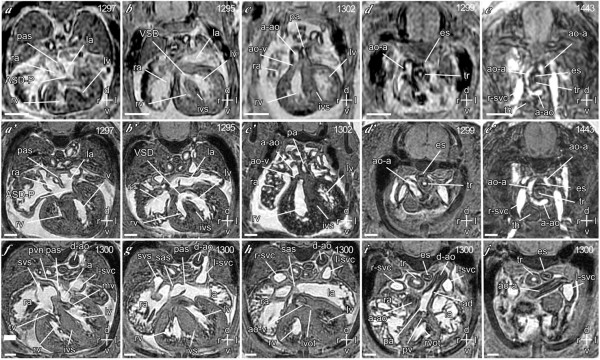
Identification of septal, outflow tract, and aortic arch malformations using multi-embryo MRI (a – e') Images of transverse sections from 5 Cited2-/- embryos obtained using the multi-embryo technique (a–e) compared with images from the same embryos obtained subsequently using the single embryo technique (a'–e'). (a, a') Section showing left and right atria and ventricles (la, ram, live, rave). The atria are separated by the primary atria septum (pas), which is deficient at its ventral margin creating an osmium premium type of atria septal defect (ASD-P). (b, b') Section showing a ventricular septal defect (VSD) in the interventricular septum (ivs). (c, c') Section showing double outlet right ventricle, wherein the ascending aorta (a-ao) and the pulmonary artery (pa) both arise from the right ventricle (rv). The aortic valve (ao-v) is indicated. (d, d') Section showing a right-sided aortic arch (ao-a) passing to the right of the trachea (tr) and the esophagus (es). (e, e') Section showing bilateral aortic arches (ao-a) forming a vascular ring around the trachea (tr) and the esophagus (es). Also indicated are the thymus (th) and the right superior vena cava (r-svc). (f – j) Serial transverse sections through a wild-type heart obtained using single embryo MRI, demonstrating corresponding normal structures, including the systemic venous sinus (svs), left superior vena cava (l-svc), pulmonary vein (pvn), descending aorta (d-ao), mitral and tricuspid valves (mv, tv), the secondary atrial septum (sas), left and right ventricular outflow tracts (lvot, rvot), pulmonary valve (pv), and arterial duct (ad) of the pulmonary artery. Scale bars = 635 μm for multi-embryo, and 317 μm for single embryo images; axes: d – dorsal; v – ventral; r – right; l – left.